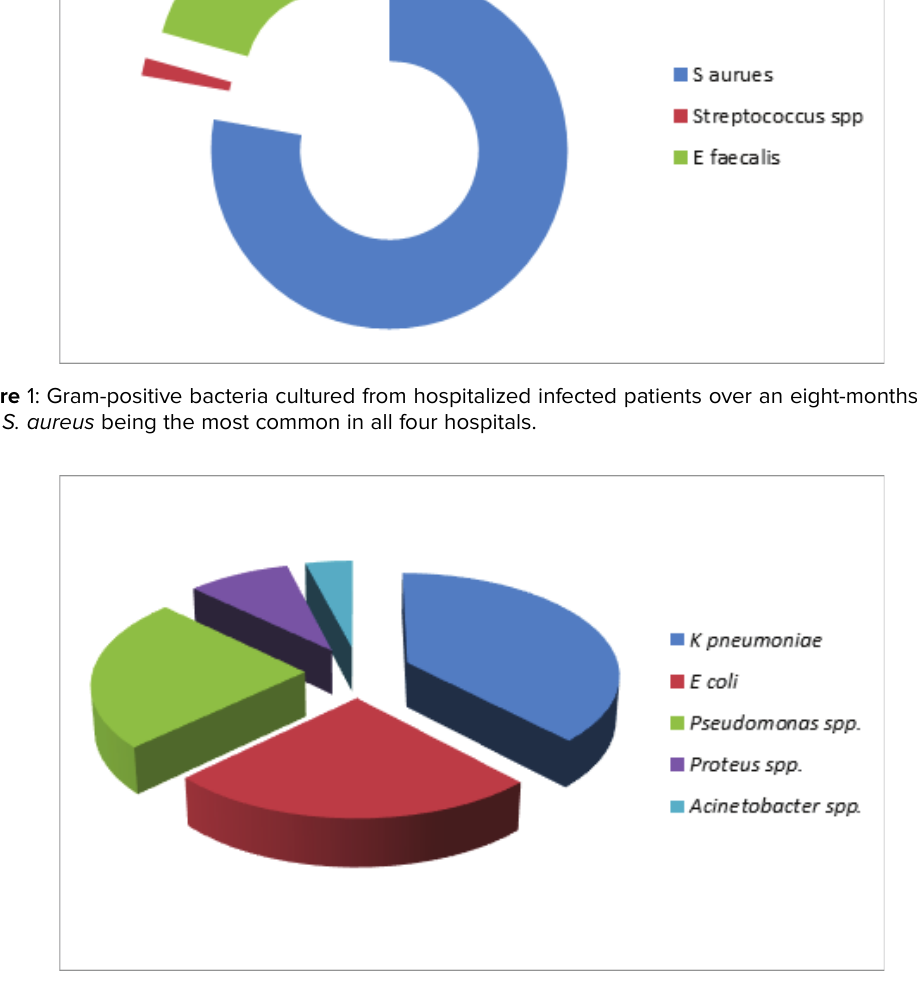
Figure 2: Klebsiella pneumoniae was the most prevalent Gram-negative isolate during the study period and Acinetobacter spp . was the least